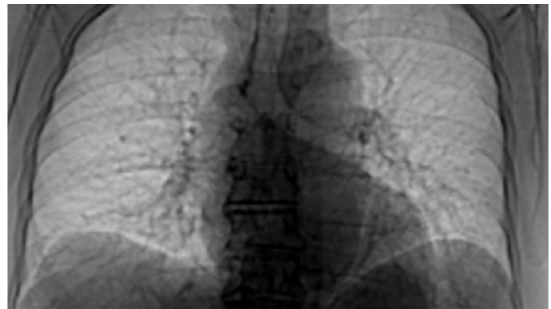
Figure 23. The image from Figure 22 in “Invert color” format. Figures 24 and 25 present the defined masks for the left lung and right lung, framed in blue borders.